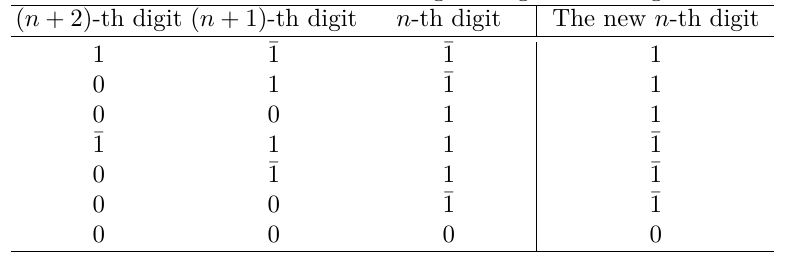
Table 3: The rule of truncating the highest two